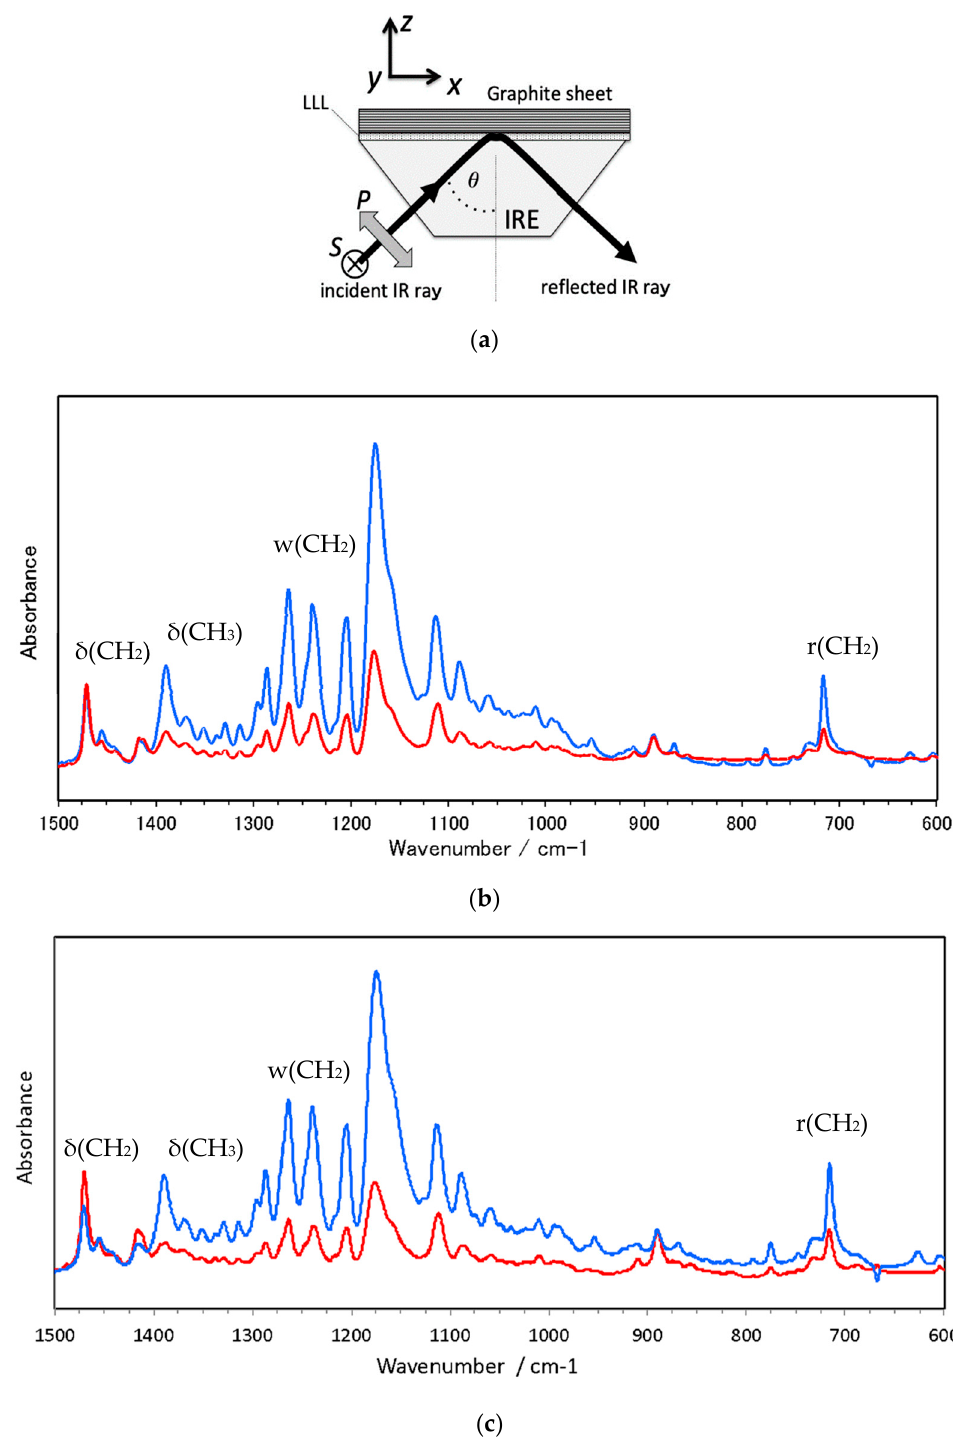
Figure 3. Polarized attenuated total reflection Fourier-transform infrared (ATR-FTIR) spectra of LLL β -form crystals with blue and red lines for p and s polarizations: ( a ) experimental arrangement, ( b ) spectra taken for LLL/graphite sheet, and ( c ) spectra taken for solution-grown single crystals, whose flat faces are set parallel to the internal reflection element (IRE) sampling face.